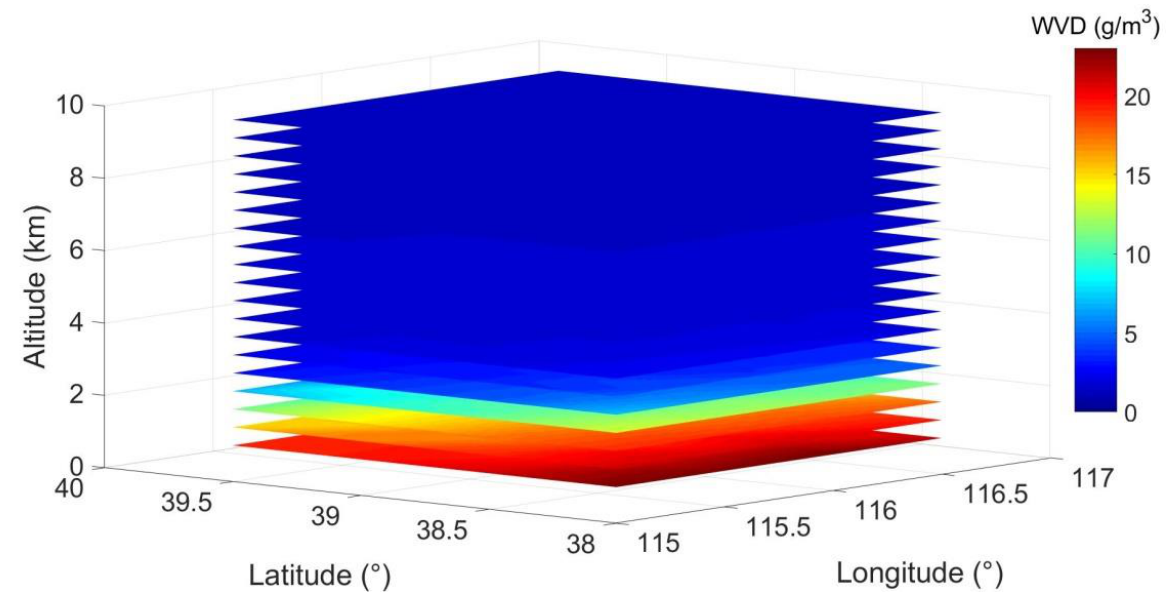
Figure 6. 3D water vapor tomography result.